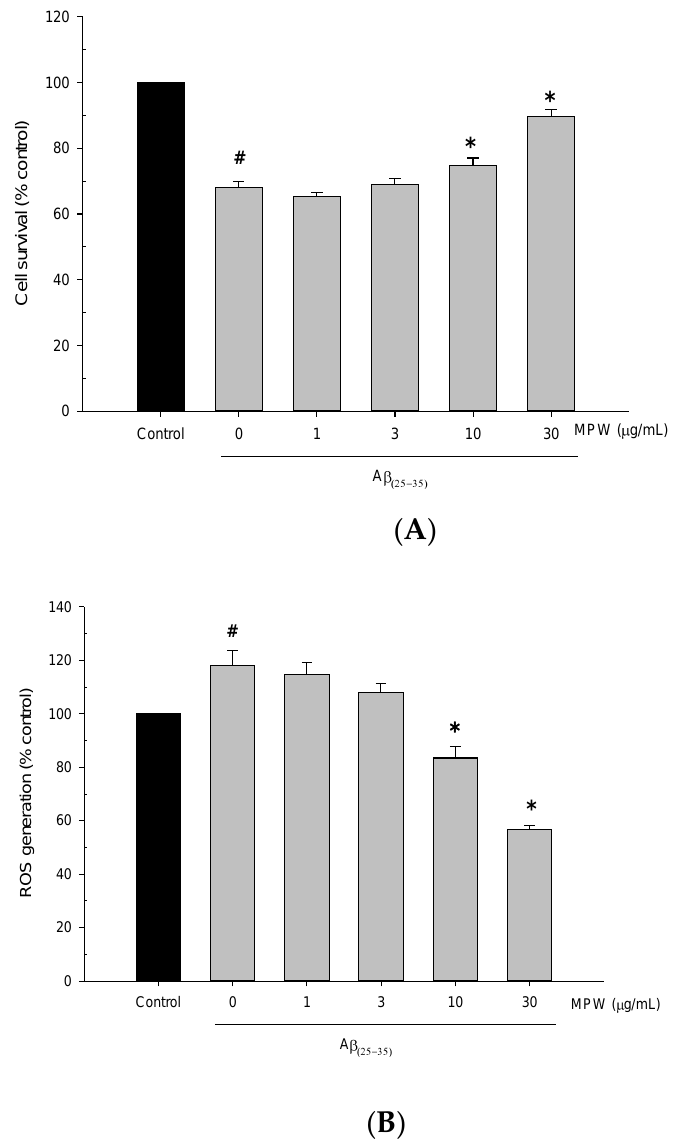
Figure 1. Effects of MPW on A β (25–35) -induced neurotoxicity and ROS generation in primary rat cortical cells. ( A ) The cultured cells were exposed to 40 µ M A β (25–35) in MEMG for 24 h in the absence or presence of MPW at the indicated concentrations. The cell viability was determined by the MTT reduction assay at 22–24 h of the exposure, as described in the Materials and Methods. The viability of each treated group is expressed as a percentage of that of the vehicle-treated control cells. ( B ) The cultured cells were pre-incubated with 10 µ M DCFH-DA for 30 min at 37 °C in the dark and then treated with 40 µ M A β (25–35) in MEMG in the absence or presence of MPW at the indicated concentrations. The intracellular ROS levels were measured by the fluorescence detection of 2′,7′-dichlorofluorescein, as described in the Materials and Methods. The ROS levels in each treated group are expressed as percentages of those in the vehicle-treated control cells. Each data point represents the mean ± S.E.M. from at least three independent experiments conducted in duplicate (#, p < 0.05 vs. the vehicle-treated control cells without MPW; *, p < 0.05 vs. the A β (25–35) -treated cells without MPW).